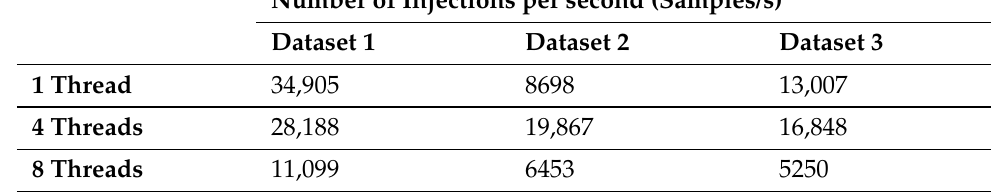
Table 7. Injections